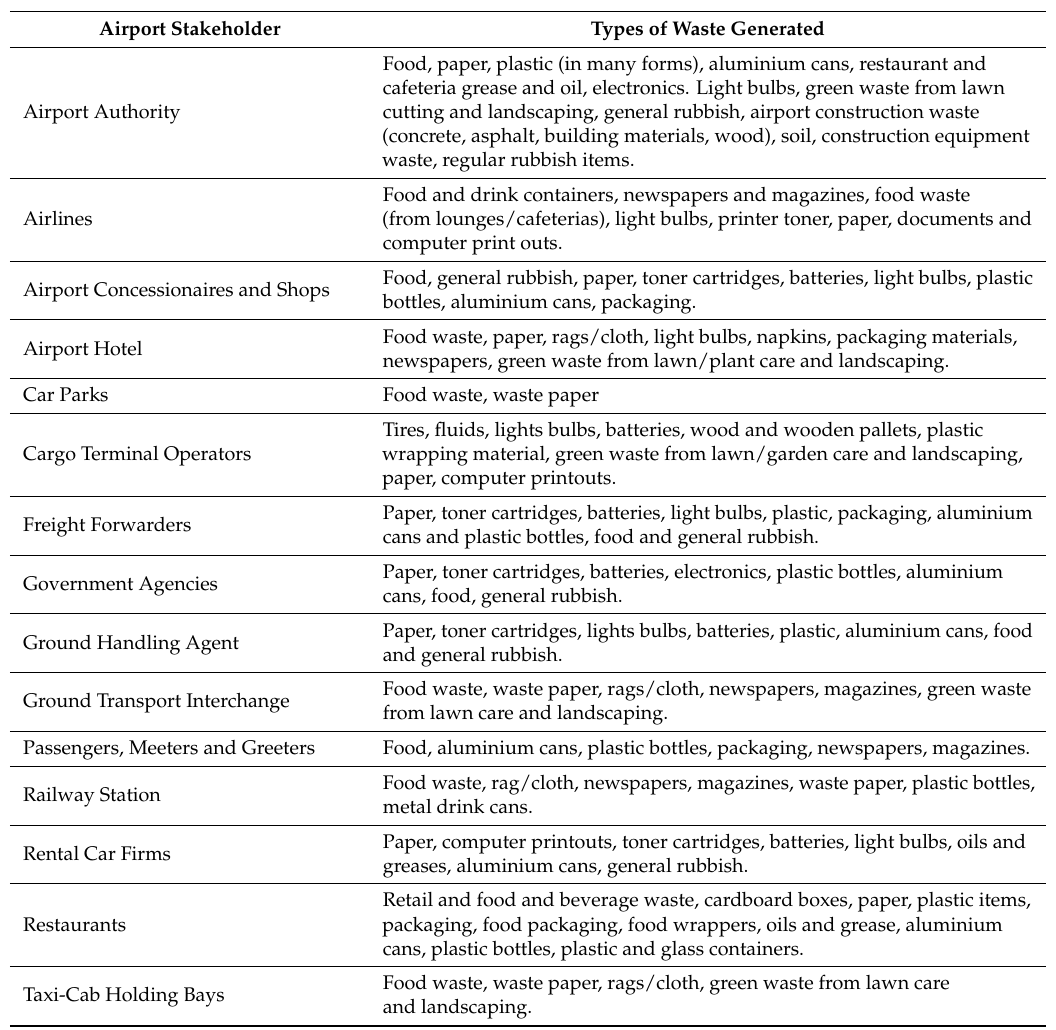
Table 1. Key airport landside stakeholders and typical types of waste